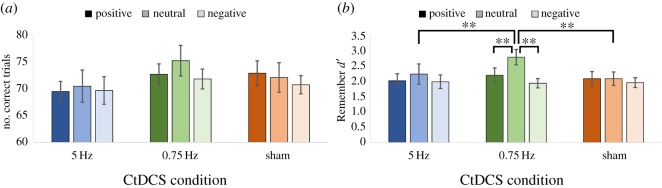
Performance on the word recognition task separately for each CtDCS condition and emotion category. (a) The number of correct trials; (b) Remember recognition performance measured by d’ (**p < 0.01).